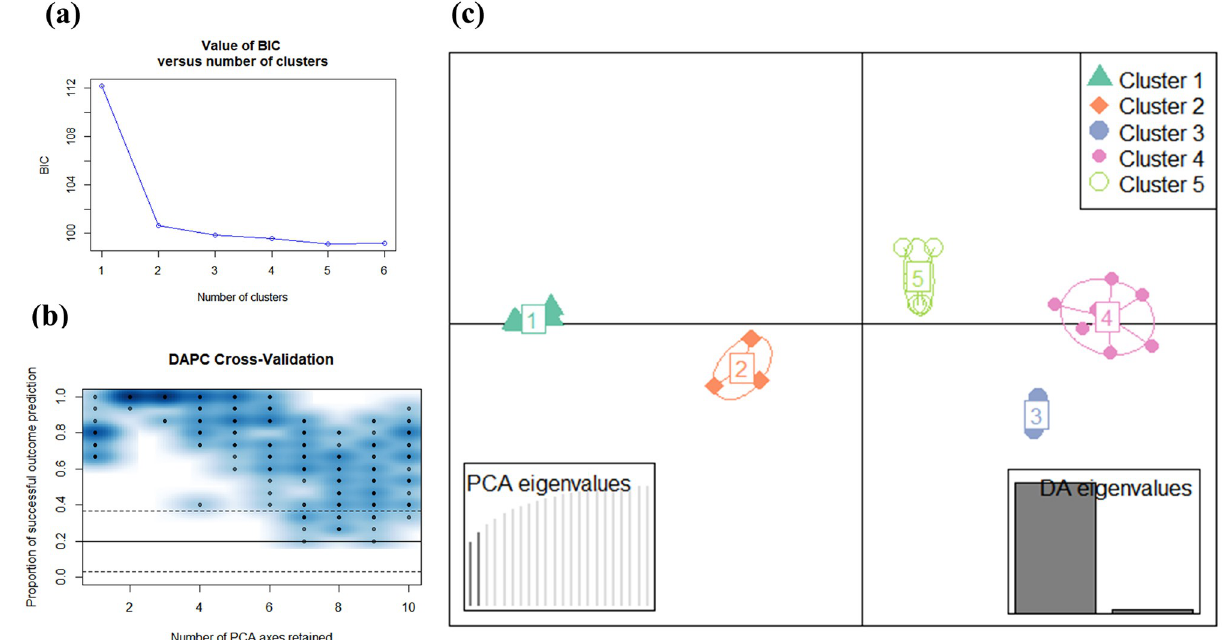
Fig 2. DAPC of 23 cannabis genotypes using 344 multiallelic structural SNPs. Clusters indicated as C1, C2, C3, C4, and C5 corresponds to the I-SNPs in Table 1.